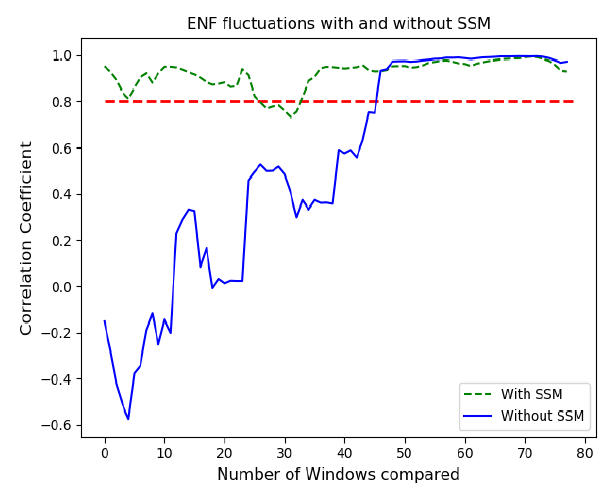
Figure 10. Correlation of Video ENF and Power ENF with and without SSM applied.